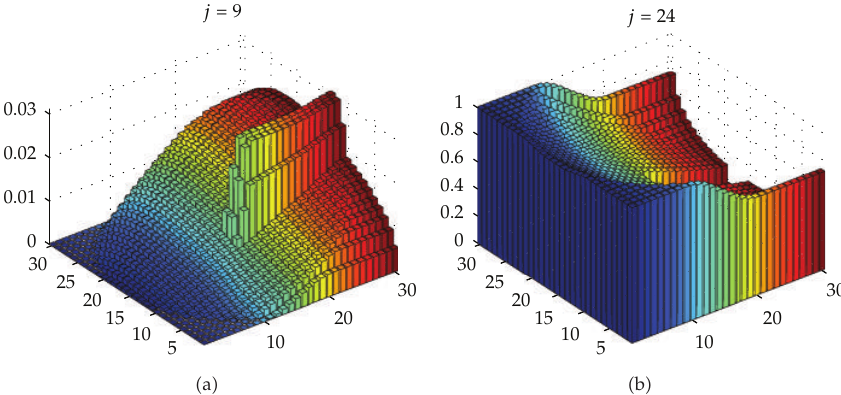
Figure 10: Selected radiation (cid:2) particles (cid:3) flux for illumination on view 24 in a high-contrast nonhomoge- neous